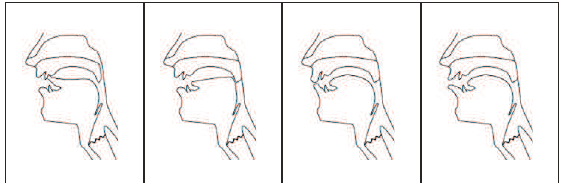
Figure 13. Sagittal sections of a talking head for the phonemes /n/, /o/, /v/,